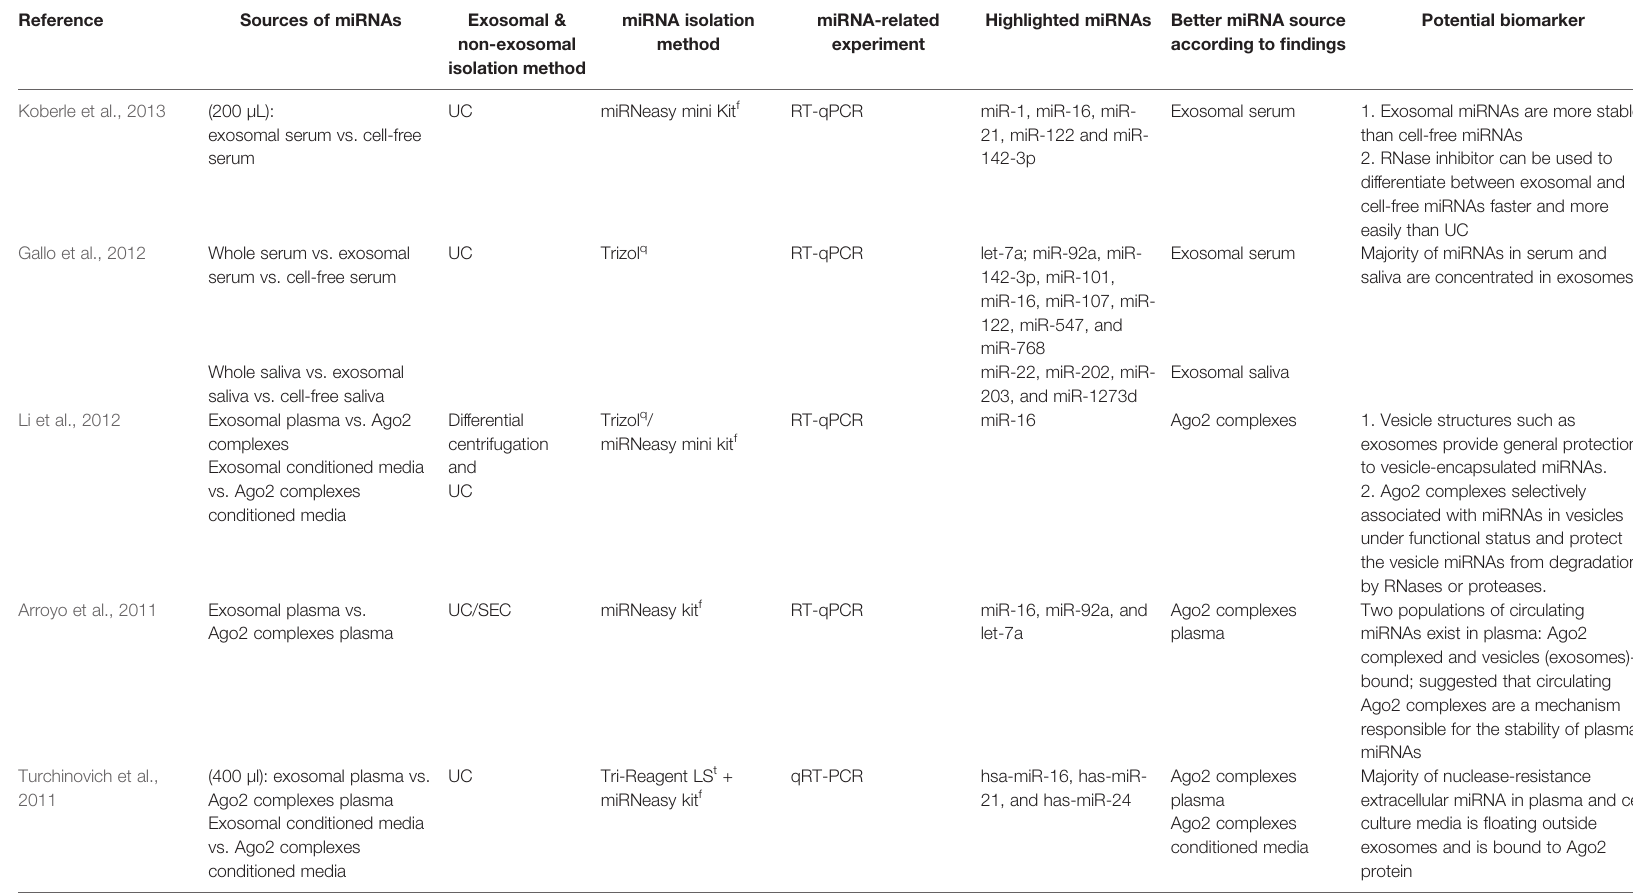
TABLE 4 | Summary of articles using different sources of miRNAs in discussing subjects other than potential biomarkers of a particular